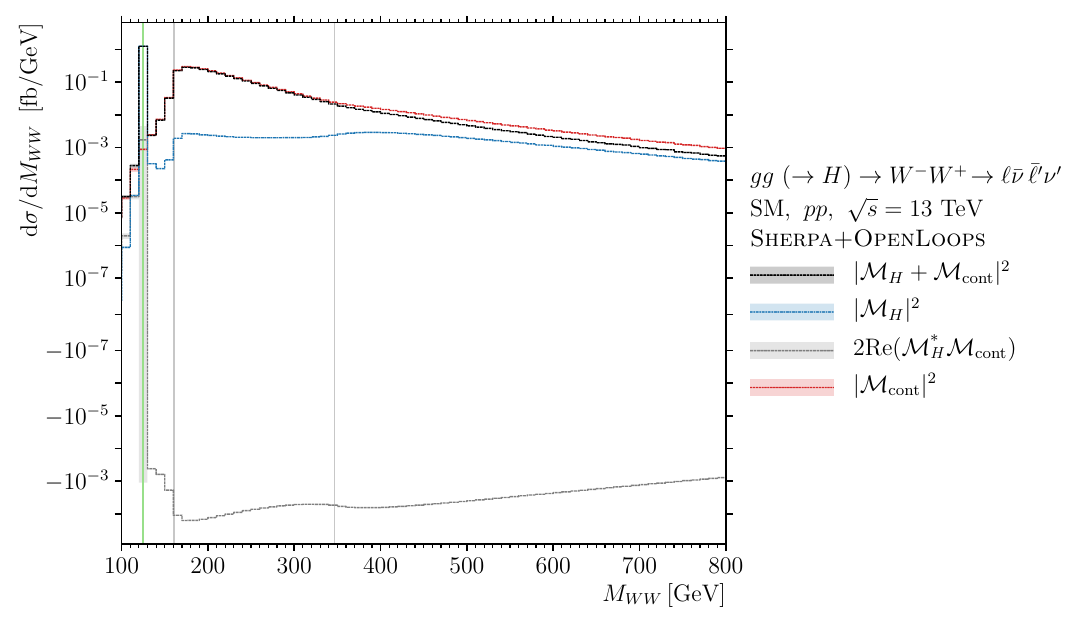
+ (cid:27) ¯ ν ¯ (cid:27) (cid:30) ν (cid:30) in the SM →